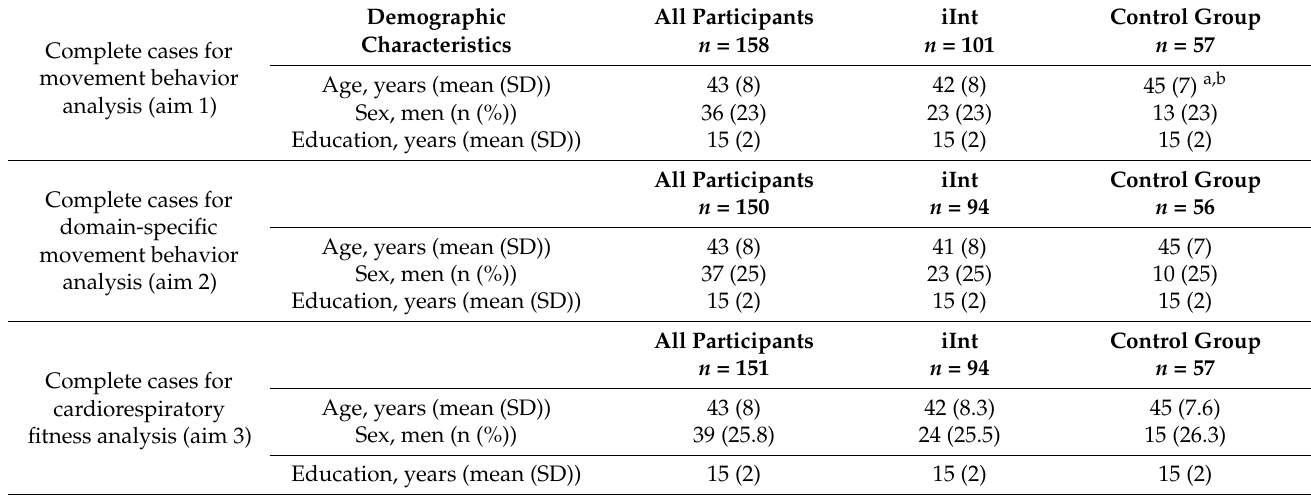
Table 3. Baseline characteristics of participants in the three different analytic samples (mean